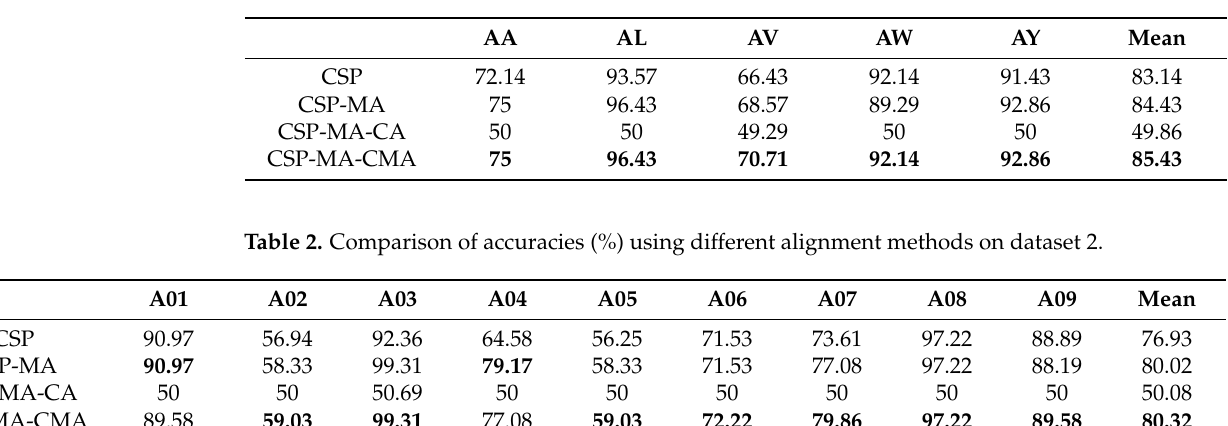
Table 1. Comparison of accuracies (%) using different alignment methods on dataset 1.